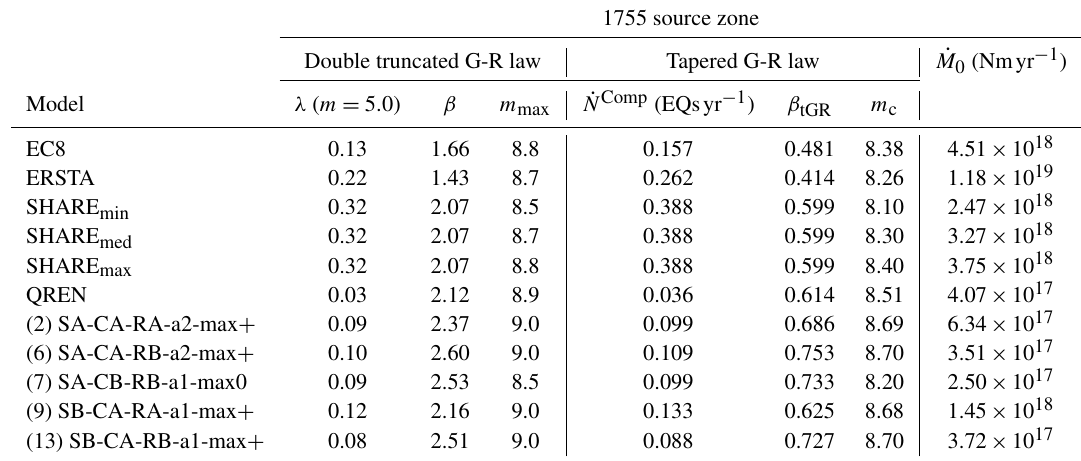
Table 7. Earthquake recurrence parameters for the 1755 source zones expressed as DTGR ( λ , β , m max ) and TGR ( ˙ N Comp , β tGR , m c ) laws, for the minimum magnitude of 5.0. ˙ M 0 is the seismic moment